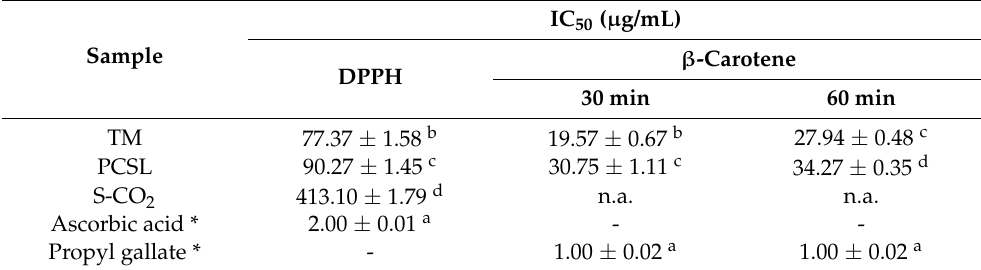
Table 3. Antioxidant activity of P. ferulacea Lindl. extracts.